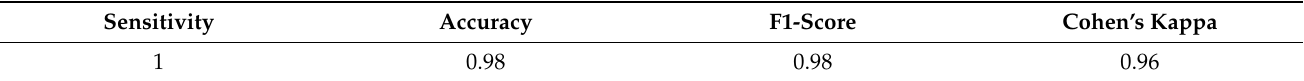
Table 3. Minimum achieved scores for the 4-bioradar system.